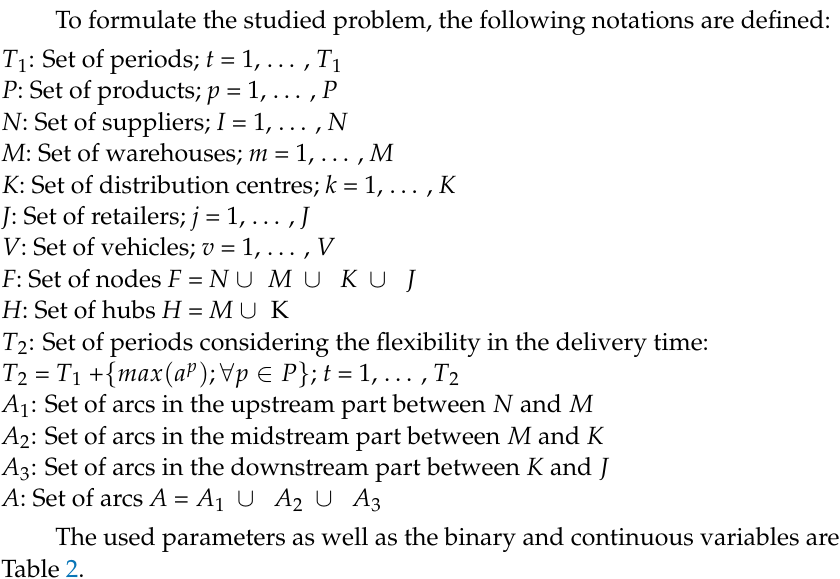
Figure 1. Example of a distribution network.